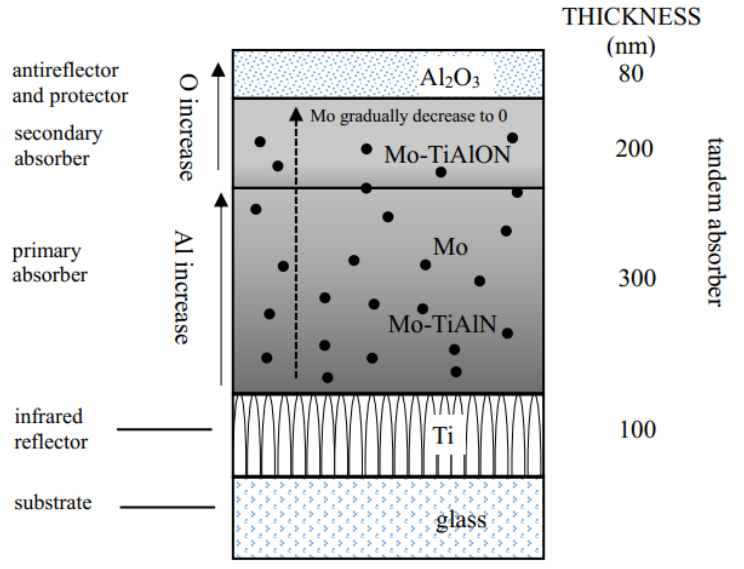
Figure 1. Cross-sectional schematic of graded-index TiMoAlON photothermal film [8]. Gradually varied bimetallic nitride, bimetallic oxynitride, and metallic oxide are im- portant for photothermal conversion. The stoichiometric ratio of each compound decides